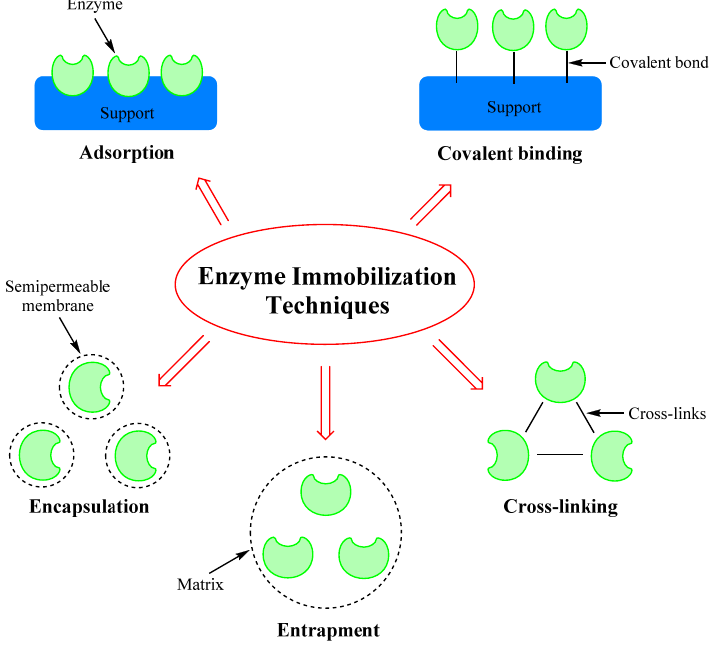
Table 2 lists the common methods of immobilizing enzymes and their advantages and disadvantages.